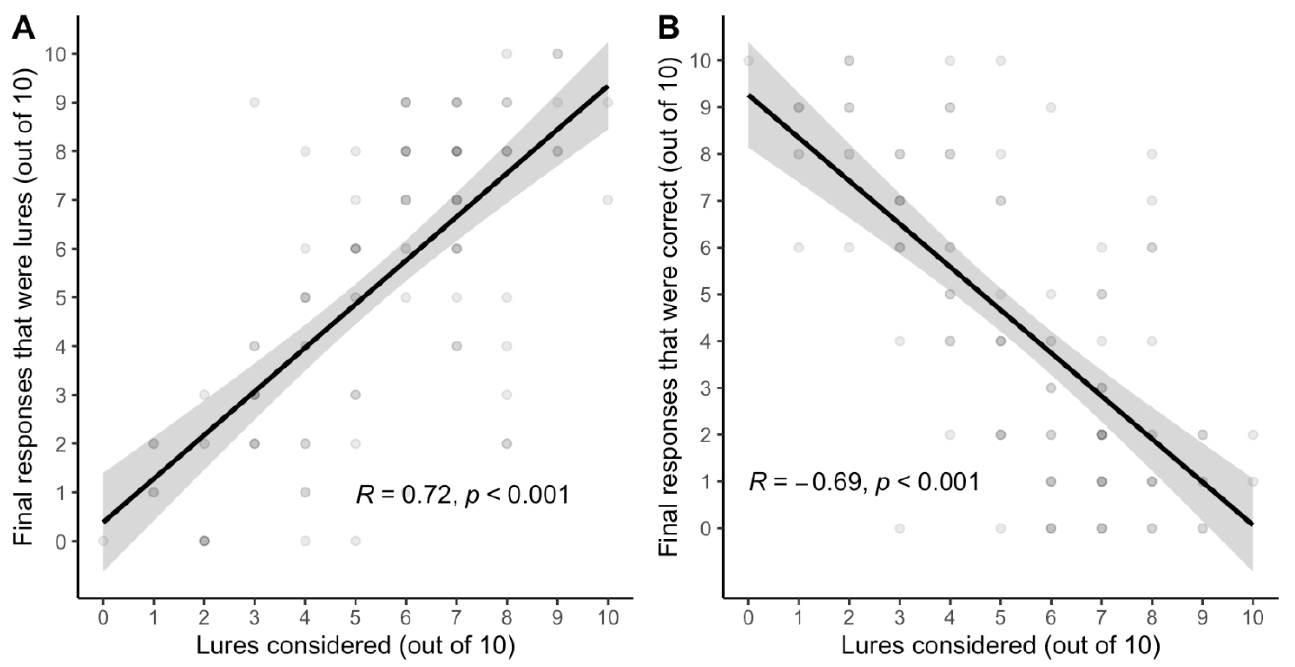
Figure 6. Correlations between consideration of lures and ( A ) acceptance of lures and ( B ) acceptance of correct responses on the verbal reflection test (vCRT) performance Study 2 (N = 102). Gray bands represent a standard